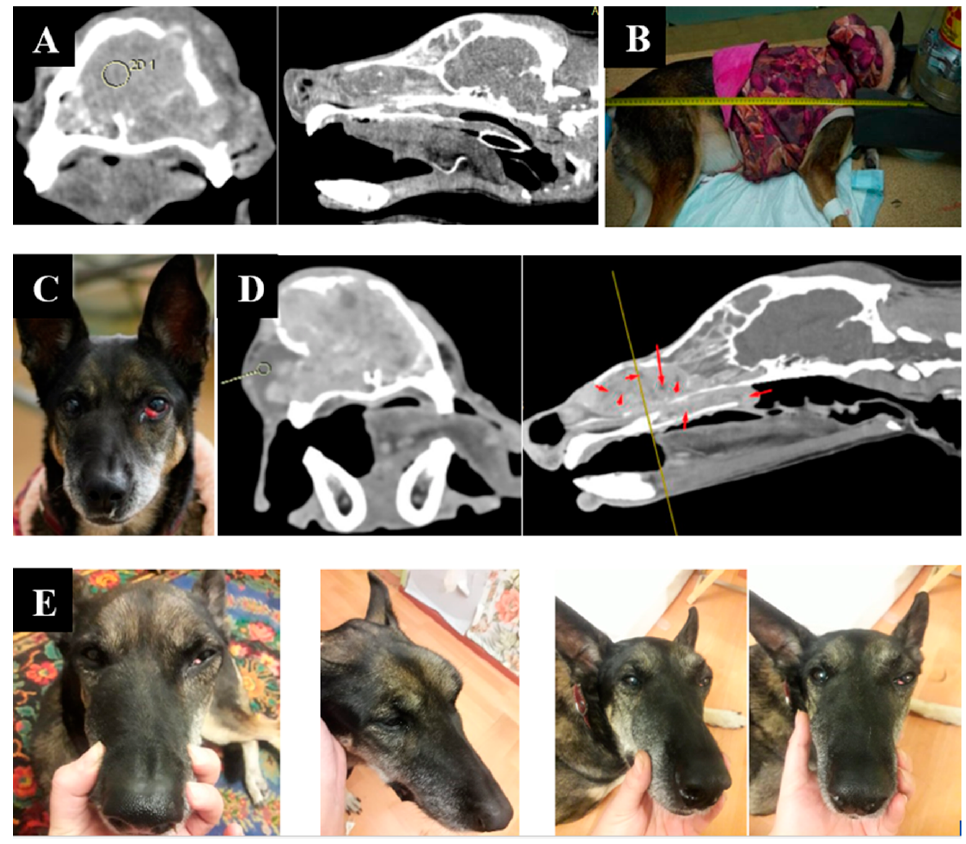
Figure 4. A dog named “Capa”. ( A )—CT of the tumor before irradiation. ( B )—positioning of the animal during the irradiation session. ( C )—type of tumor before irradiation. ( D )—Tumor reduction according to CT data after irradiation. ( E )—tumor dynamics 1, 2, and 3 weeks after irradiation. 3.5. Case 5. Sabrina —a female cat, age unknown.